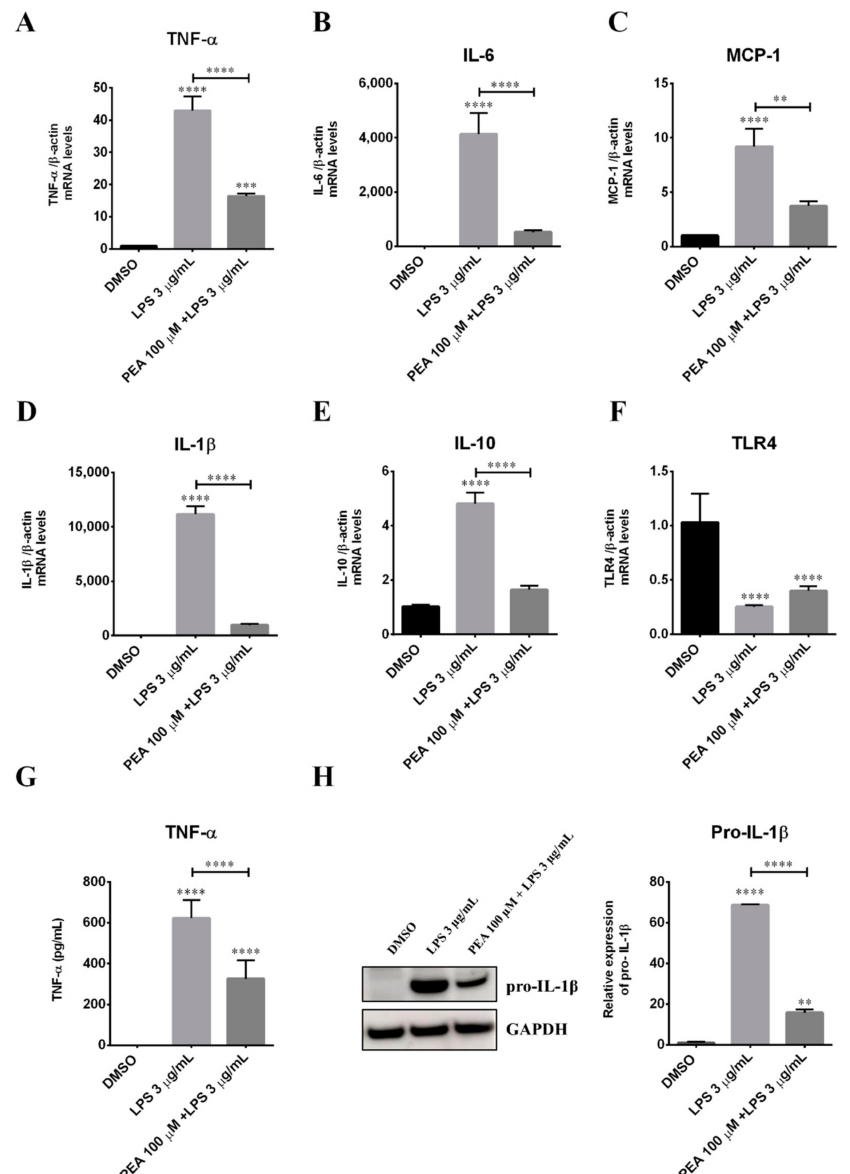
Figure 2. Effect of PEA on LPS stimulation of inflammatory cytokines in N9 cells. Cells were incubated with PEA 100 µ M for 1 h and then LPS 3 µ g/mL was added for 6 h. mRNA levels of ( A ) tumor necrosis factor alpha (TNF- α ), ( B ) interleukin-6 (IL-6), ( C ) monocyte chemoattractant protein-1 (MCP-1), ( D ) interleukin-1 beta (IL-1 β ), ( E ) interleukin-10 (IL-10) and ( F ) toll-like receptor 4 (TLR4) were examined by real-time PCR. β -actin mRNA was used for data normalization. Data are shown as the mean ± S.E.M. of measurements obtained in three independent experiments ( n = 18). ( G ) Release of TNF- α into the culture medium was quantified by using a specific enzyme-linked immunosorbent assay (ELISA). Data are shown as the mean ± S.E.M. of measurements obtained in three independent experiments ( n = 3). ( H ) IL-1 β protein expression was measured by Western blotting. To ensure equal loading, blots were also probed with anti-GAPDH. Data are shown as the mean ± S.E.M. of measurements obtained in three independent experiments ( n = 3). Differences between groups were tested for significance by applying the ANOVA test and Tukey post hoc test. ** p < 0.01, *** p < 0.001, **** p <